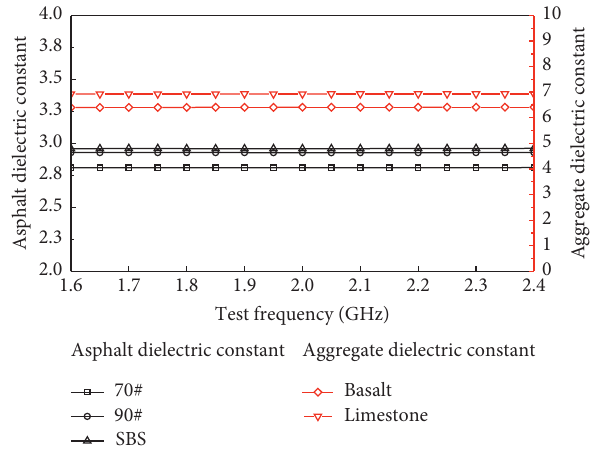
Figure 5: The dielectric constant of the single-phase materials.